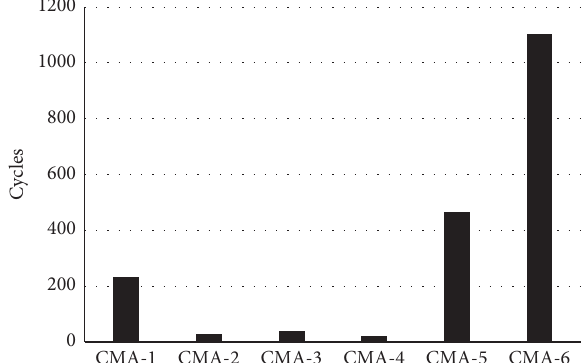
Figure 13: Results of UK wheel tracking test.